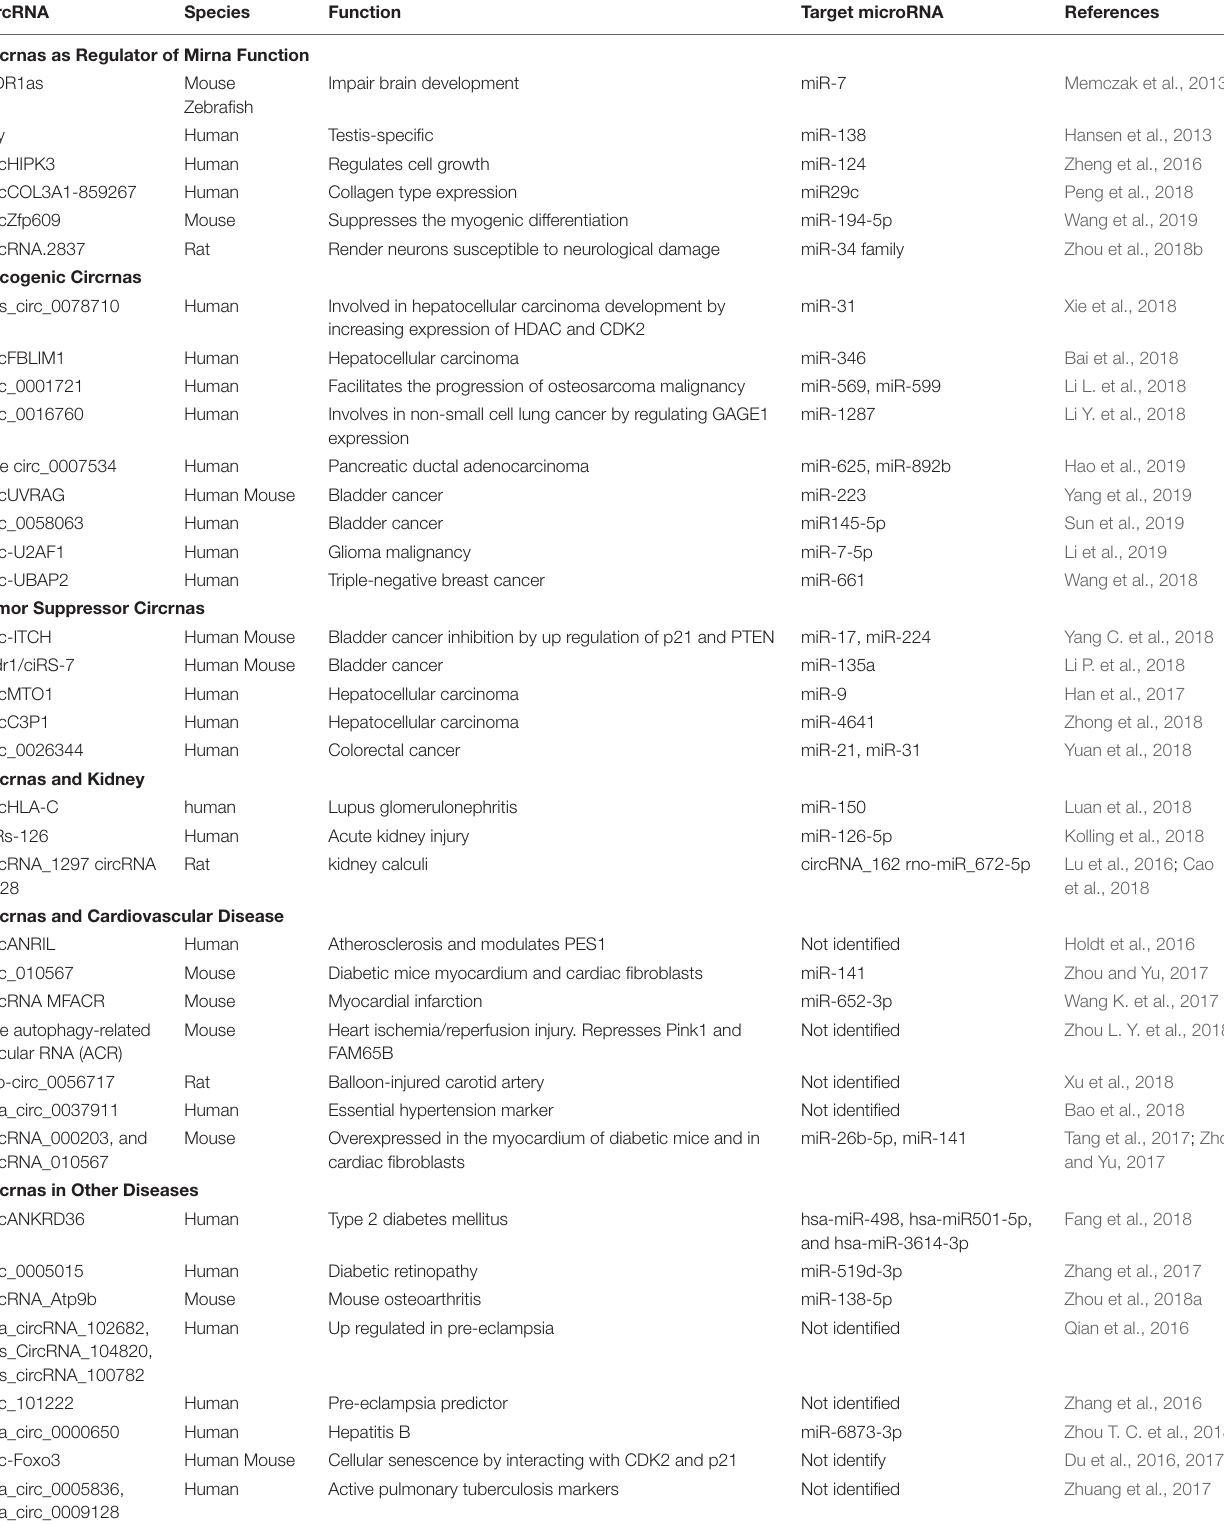
TABLE 1 | Summary of circRNAs and their functions in health and